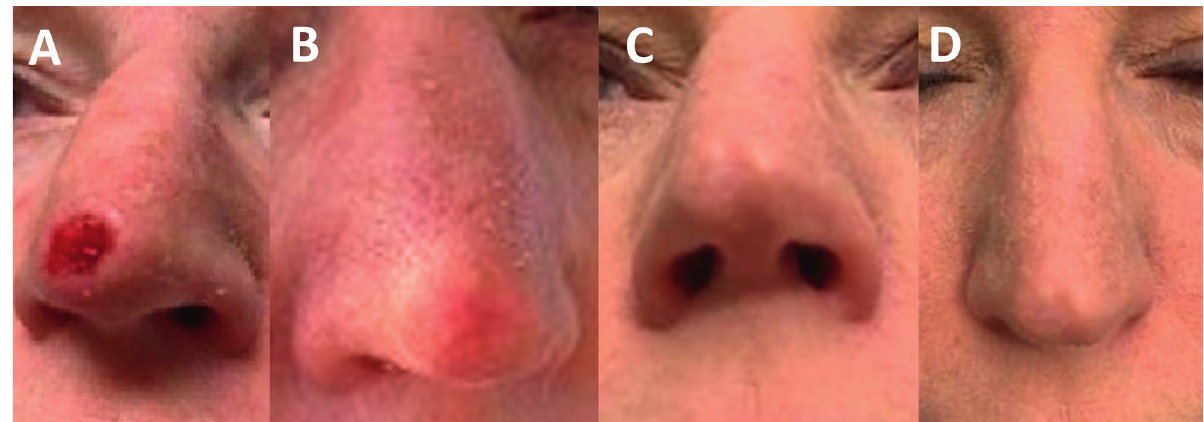
Figure 4: Evident peripheral epithelization from around the edge by two weeks (a); after a final UC graft was applied, the wound was fully reepithelialized and closed at four weeks (b). At one year and 5 months after MMS with UC (c, d) the wound is fully matured revealing a soft nasal tip with matched contour, color, and texture to the surrounding area and maintained the normal nasal tip light